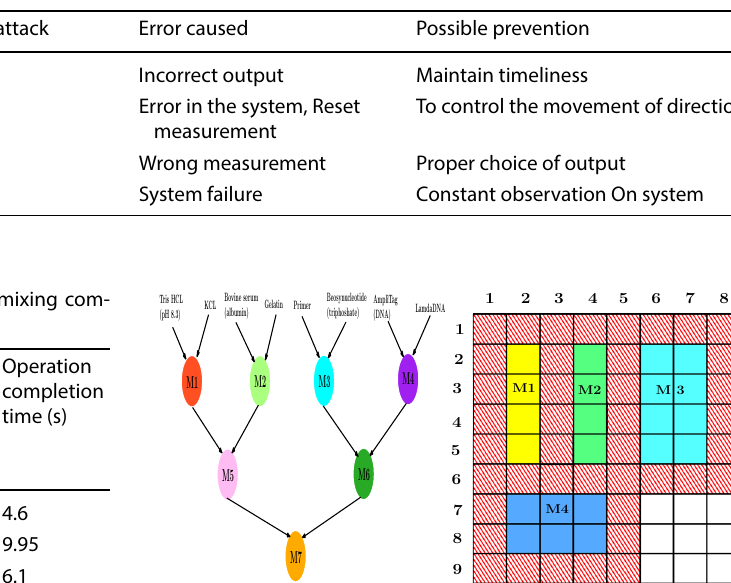
Table 1 Various attacks in cyberphysical domain [6] Sl.No.